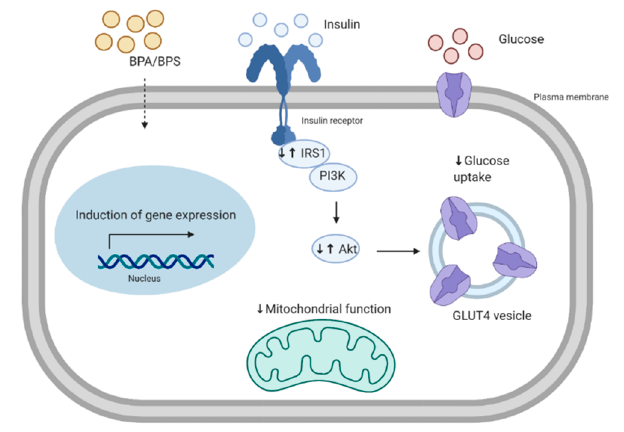
Figure 3. Mechanism of action of BPA/BPS on glucose metabolism in the skeletal muscle. BPA and BPS can bind to various receptors (as described in Figure 2) and alter gene expression. In muscle cells, it is not completely understood which receptors BPA and BPS bind to and induce metabolic alterations. Changes that have been shown in the skeletal muscle following chronic bisphenol exposure include reduced insulin signaling (reduced insulin receptor substrate 1 (IRS1) and Akt phosphorylation), and reduced mitochondrial function, both of which can lead to reduced glucose uptake. Image created with BioRender.com.